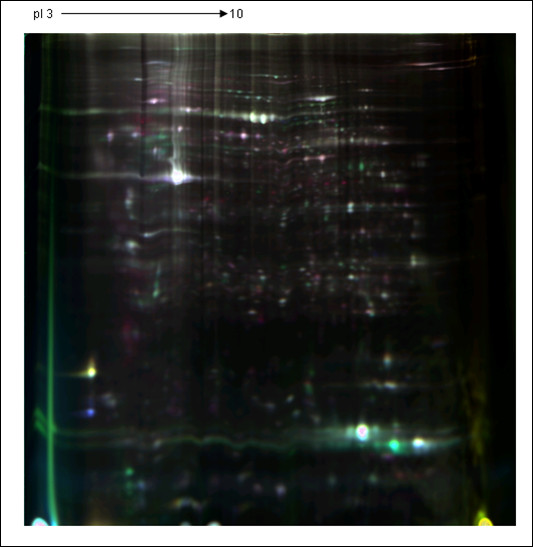
A representative 2D-DIGE picture of an overlay of three dye scan. Proteins were extracted as described and separated in pH 3-10 of 13 cm IPG strips for the first dimension and 12.5% acrylamide for the second dimension. Image was acquired on a Typhoon 9400 scanner. Dots represent spots detected by Decyder software. Cy2 (blue) image of proteins from an internal standard is the pool of all the samples, Cy3 (green) image of proteins from control1, and Cy5 (red) image of proteins from H168_2.